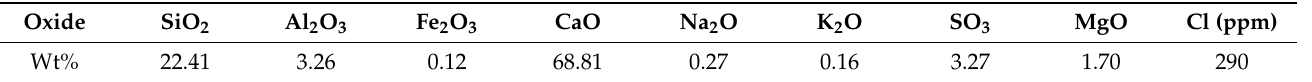
Table 2. Chemical properties of